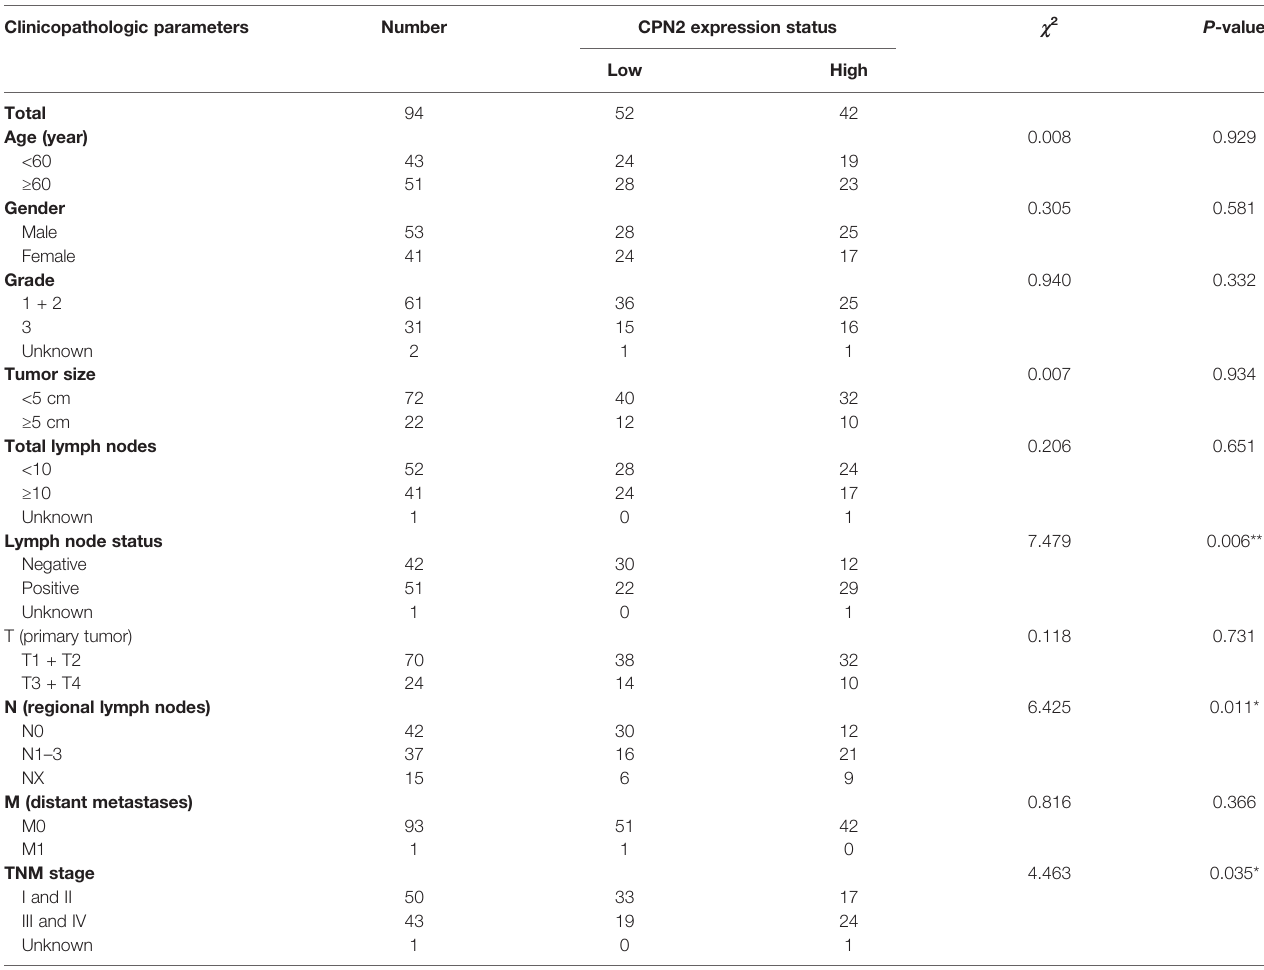
TABLE 1 | Clinical factor and CPN2 expression in lung cancer